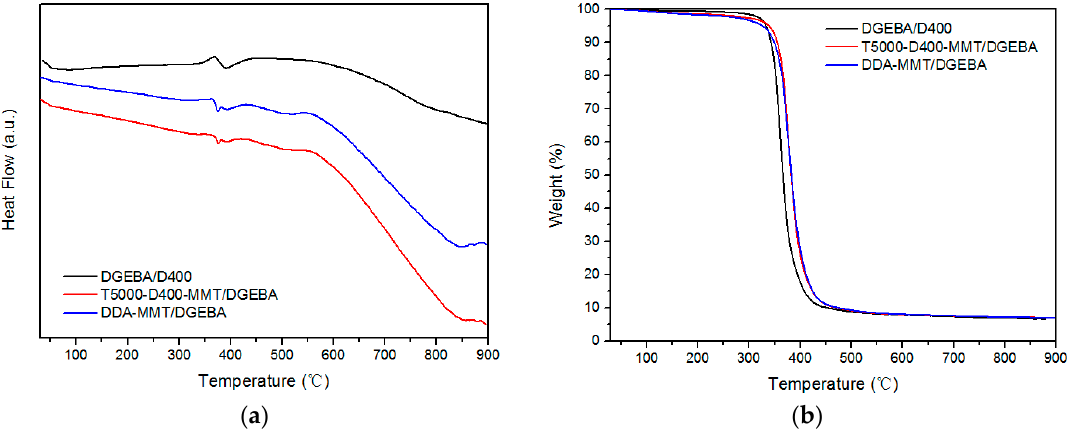
Figure 9. DSC ( a ) and TG ( b ) curves of neat DGEBA/D400, T5000-D400-MMT/DGEBA nanocomposite and DDA-MMT/DGEBA nanocomposites. Table 5. Decomposition temperatures for DGEBA/D400, T5000-D400-MMT/DGEBA nanocomposite and DDA-MMT/DGEBA nanocomposites.